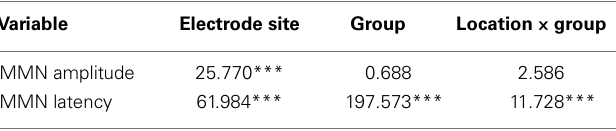
Table 2 |The effects of electrode location and group on ERP amplitude and latency